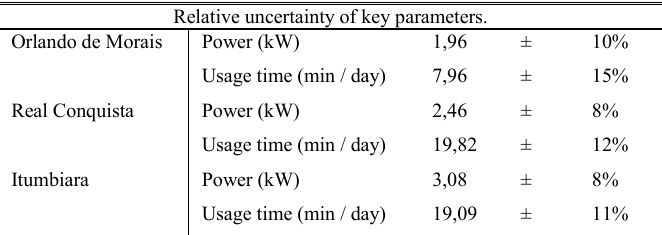
TABLE V C OMPARATIVE OF THE U NCERTAINTY C ALCULATED FOR R EDUCTION IN THE D EMAND OF T IP IN THE C ASE S TUDIES Relative uncertainty of key parameters. Orlando de Morais